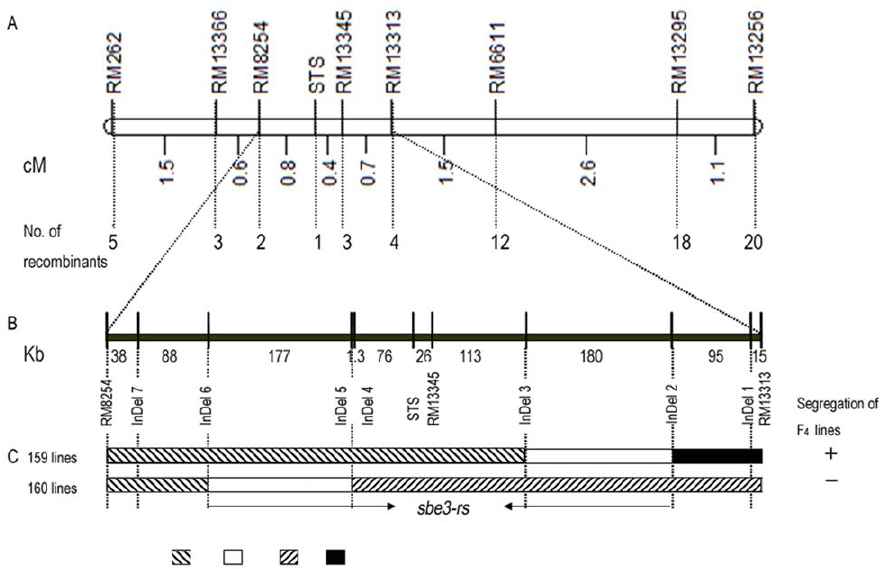
Figure 4. Schematic representation of the region on rice chromosome 2 harboring sbe3-rs . A: High-resolution genetic map built with eight SSRs and a STS markers: numbers between the markers indicate genetic distance (cM), and the number of recombinants was among extreme low RS content plants. B: Physical maps between SSR marker RM8254 and RM 13313. C: Recombinant genotypes and their corresponding phenotypes. + , indicates RS content segregating in F 4 line; 2 indicates no segregation in F 4 line. : Genotypes between two flanking markers are